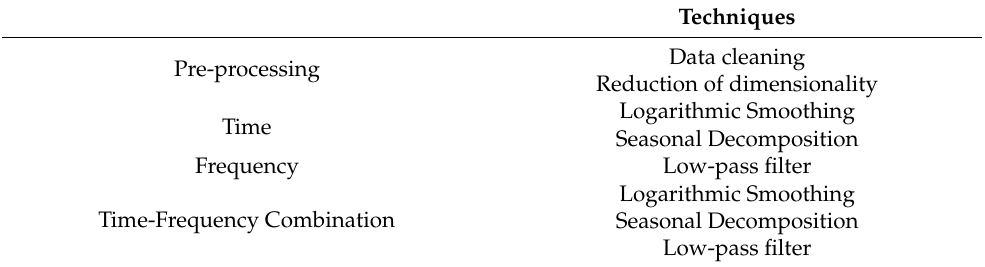
Table 3. Applied processing techniques.